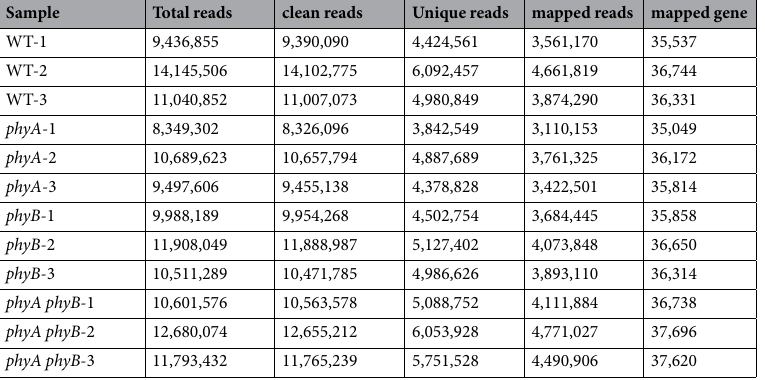
Table 1. Overview of reads from phyA and phyB single and double mutants and wild-type (WT) rice